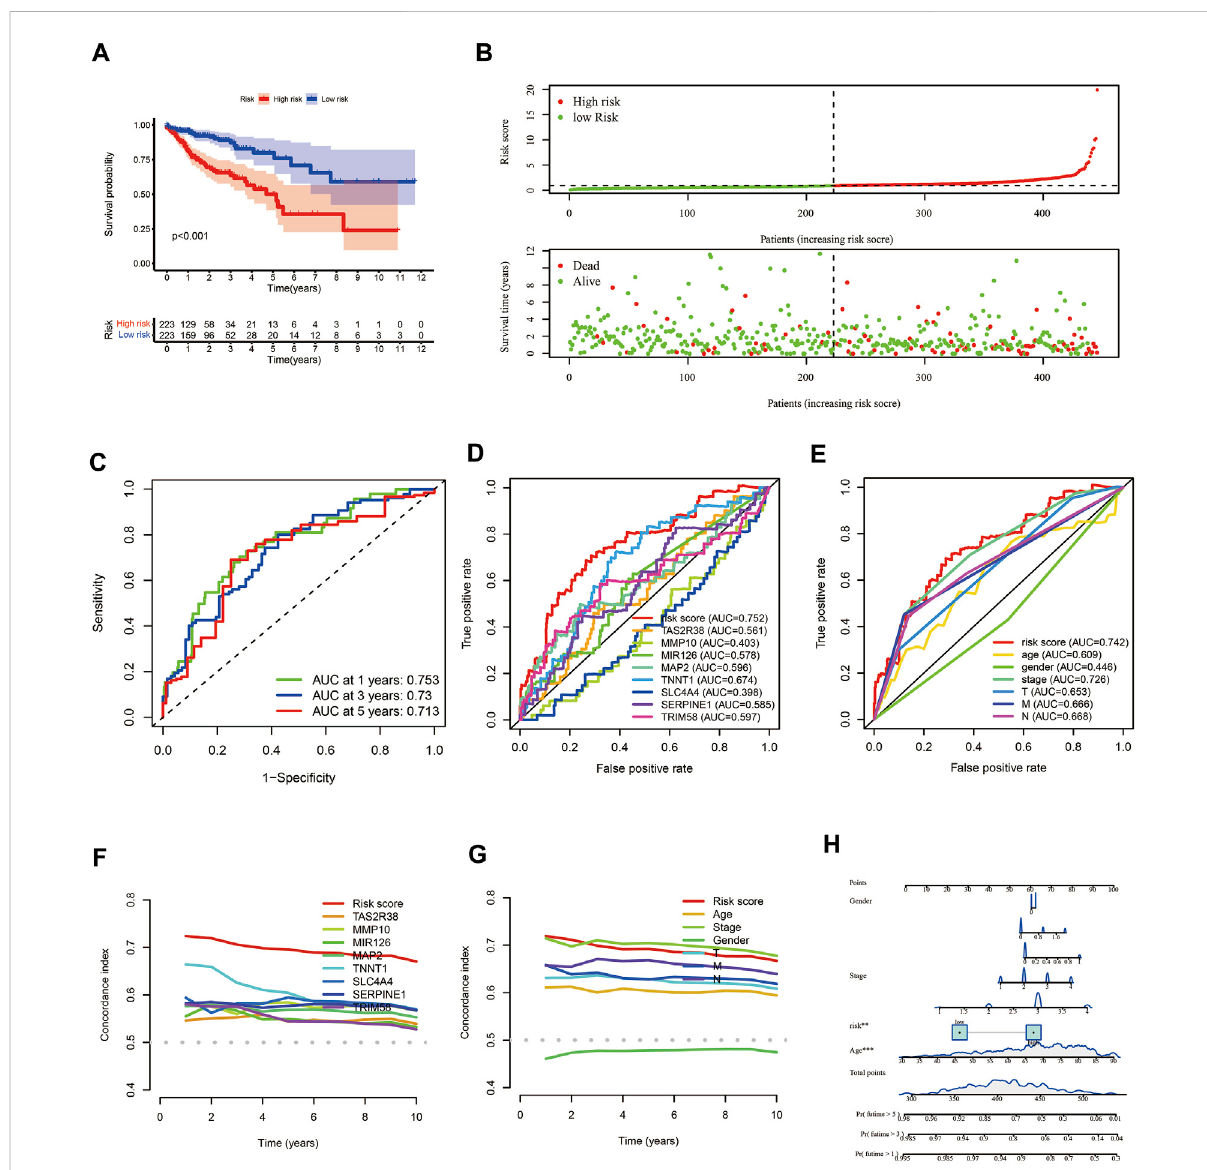
FIGURE 6 EvaluationofprognosticmodelsforCOADpatients. (A) KMsurvivalanalysis. (B) RiskscoresandsurvivalstatusofCOADpatients. (C) ROCcurves of1,3and5years. (D,F) ROCcurvesandC-indexplotsforthemodelandthegenesusedtoconstructthemodel,respectively. (E,G) ROCcurvesand C-index plots of the model and the patient ’ s clinical information, respectively. (H) The nomogram prediction model constructed by using risk score andclinicalinformationofCOADpatients.COAD:colonadenocarcinoma;KM:Kaplan – Meier;ROC,receiveroperatingcharacteristic;C-index: concordance